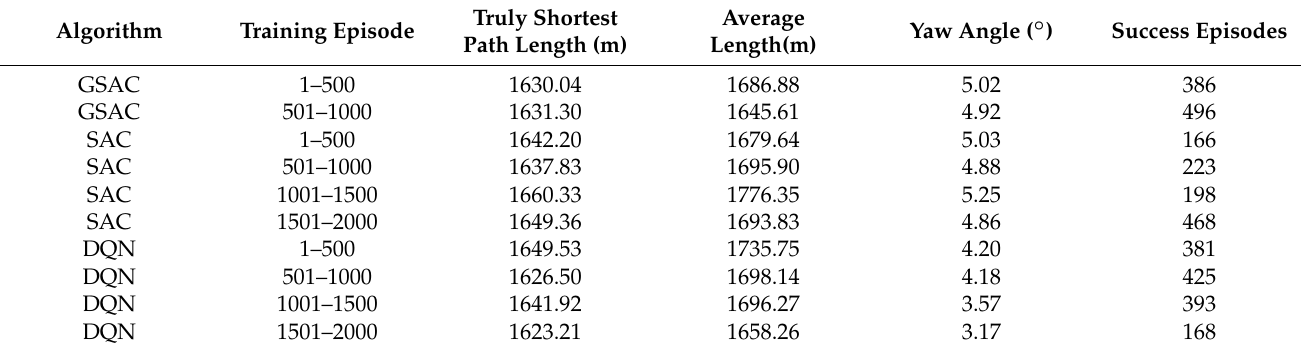
Table 5. Dynamic environment simulation result.